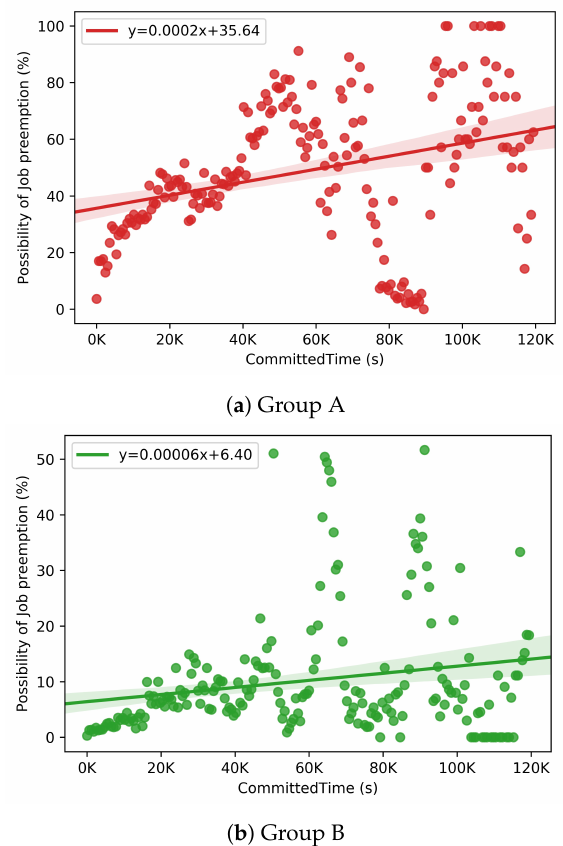
Figure 11. Probability of preempted jobs by committed time until Percentile